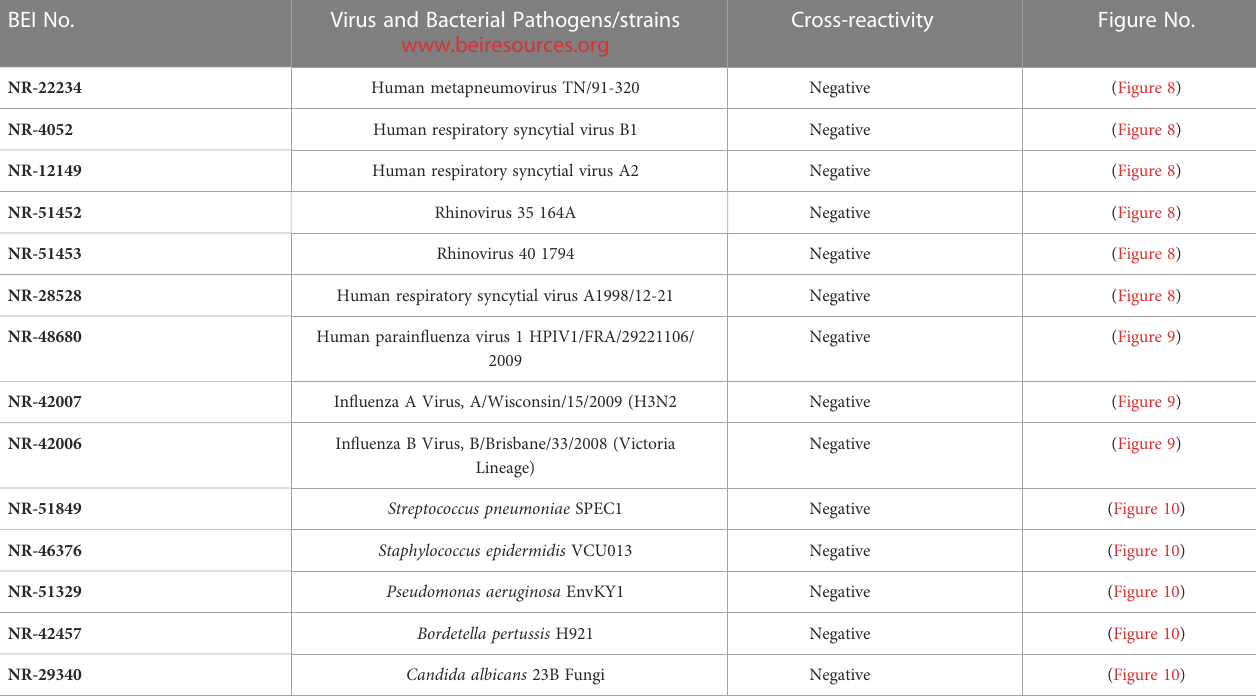
TABLE 3 LFIA Speci fi city/Cross-reactivity with FDA approved pathogen Panel. BEI No. Virus and Bacterial Pathogens/strains www.beiresources.org